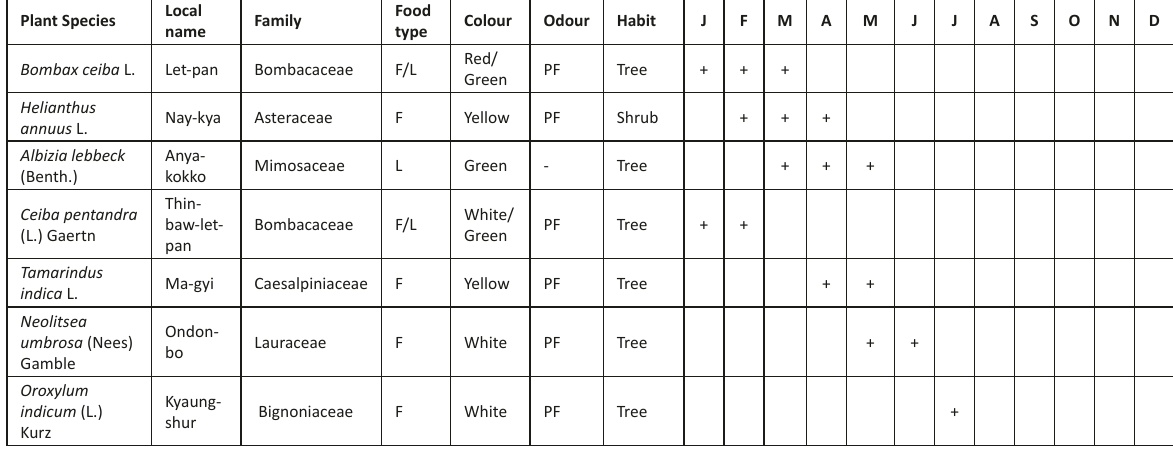
Table 2. Chewed leaves and flowers (ejecta) collected beneath day roosts of P. giganteus. Plus sign indicates months in which flower or leaf was